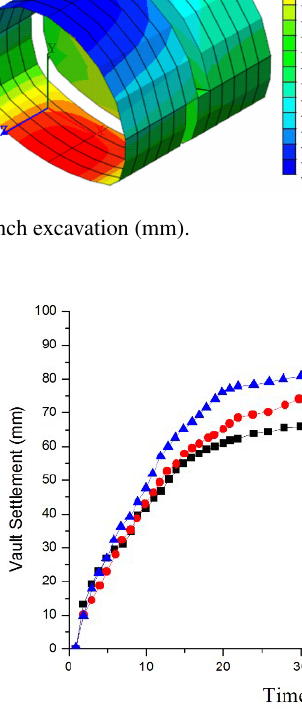
Figure 16. Settlement–time curve of the vault supported by the bench